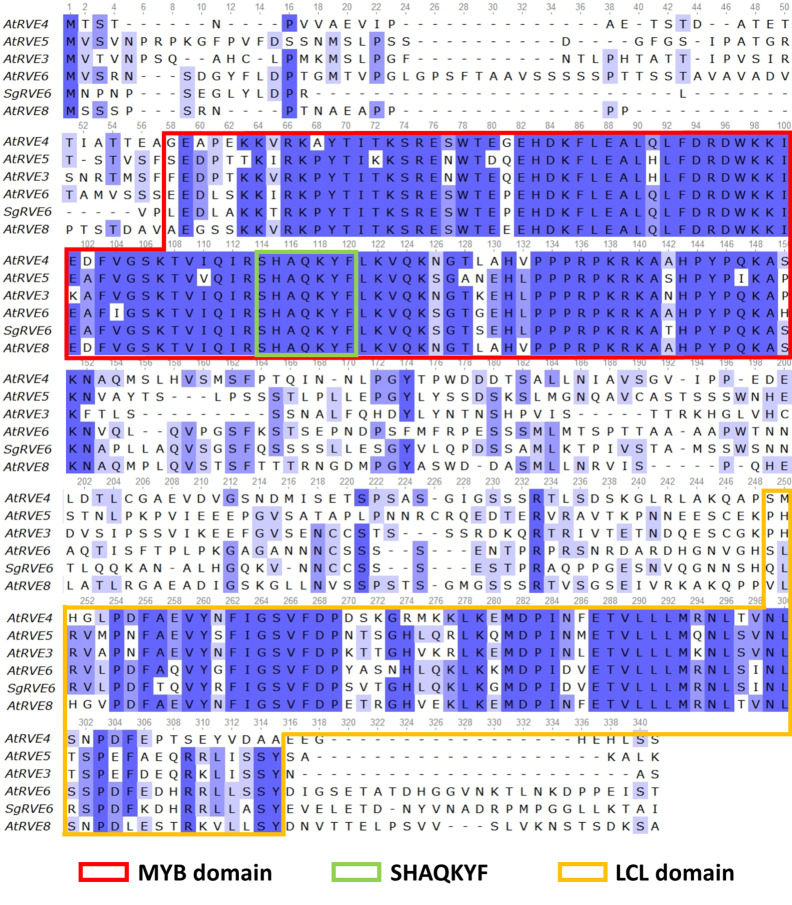
Amino acid sequence alignment of the Arabidopsis thaliana LHY/CCA1-LIKE (LCL) subfamily and SgRVE6. The alignment was performed using the T-Coffee multiple sequence alignment. The blue backgrounds correspond to percent identity of the multiple alignment. The boxes delimit the MYB domain (red), the SHAQKYF motif (green) and the LCL domain (yellow).